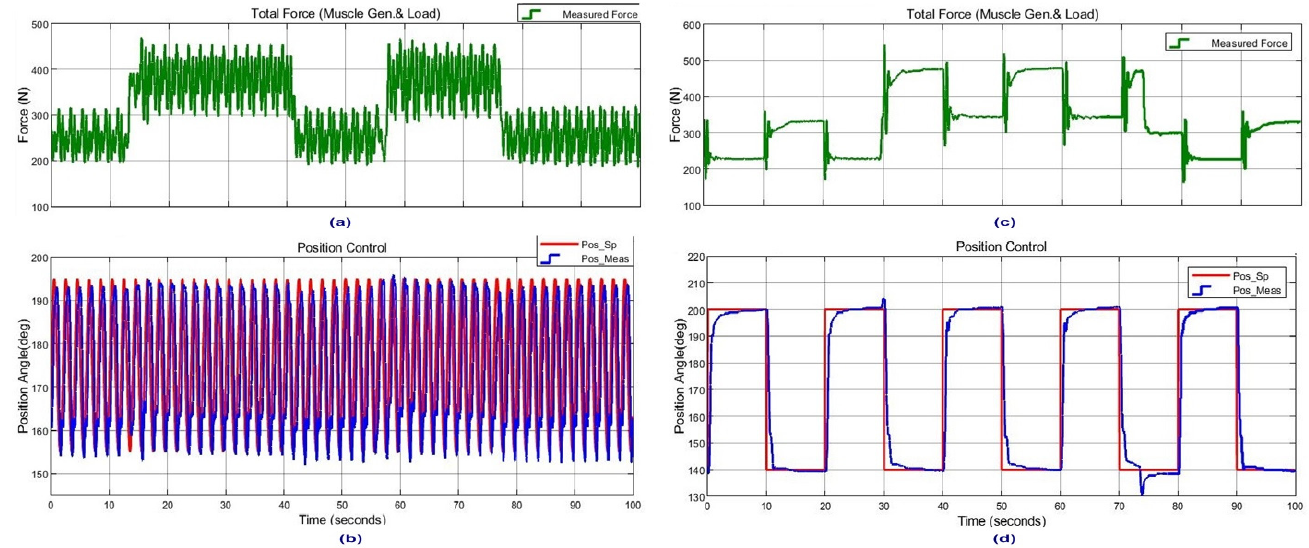
Figure 24. External load addition and removal performance comparison results: ( a , b ) for 0.50 Hz sinusoidal reference position tracking and ( c , d ) for step reference position tracking.